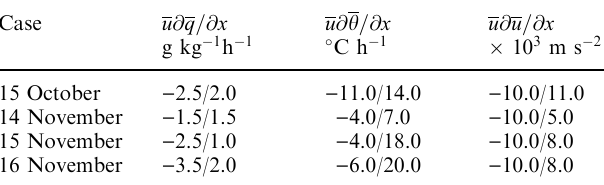
Table 3. Extreme values attained by horizontal advection of moisture, potential temperature and horizontal wind in the mountain wave